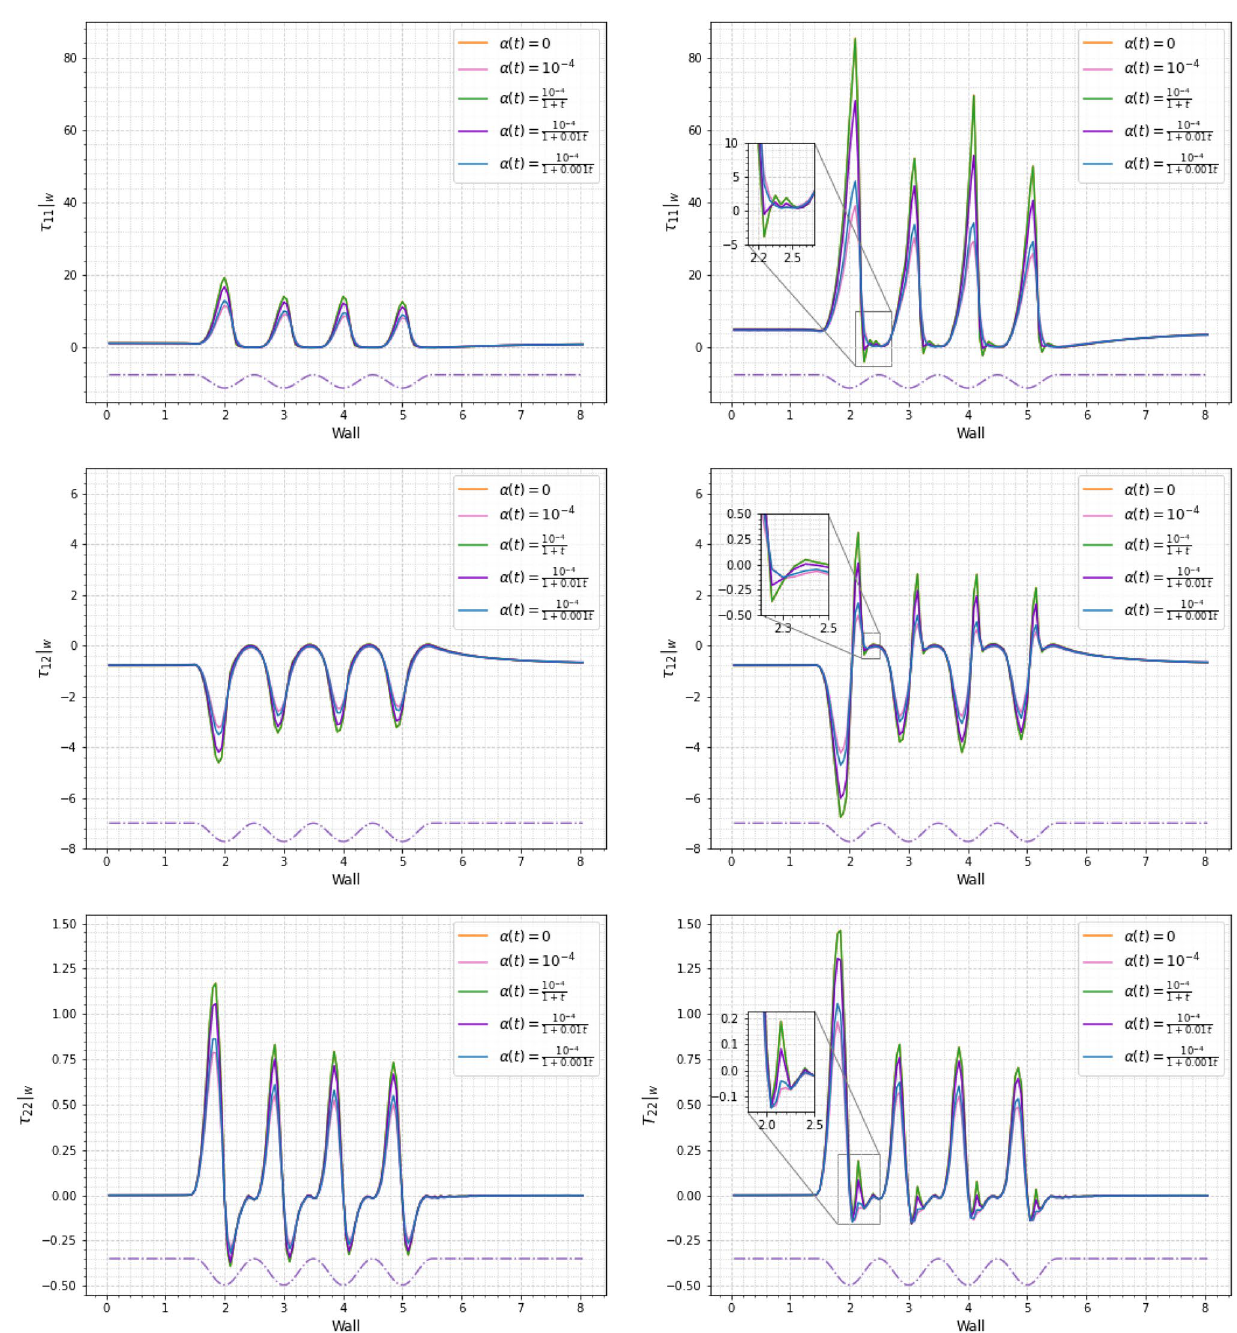
Fig. 6 Behavior of the extra stress component 𝜏 along the channel wall for different values of parameter 𝜀 of diffusion coefficient 𝛼 ( t ) = 10 − 4